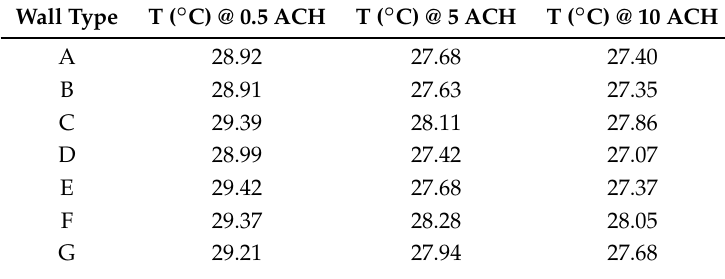
Table 3. Max zone operative temperature values (17